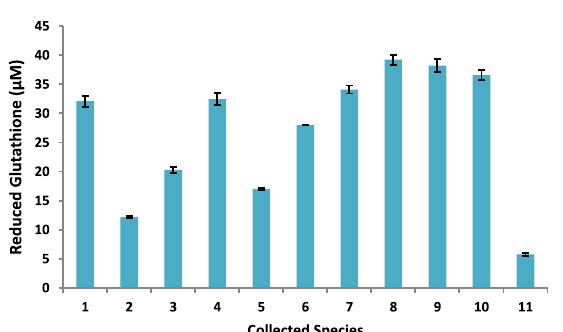
Fig. 2 Level of reduced glutathione in the collected fish